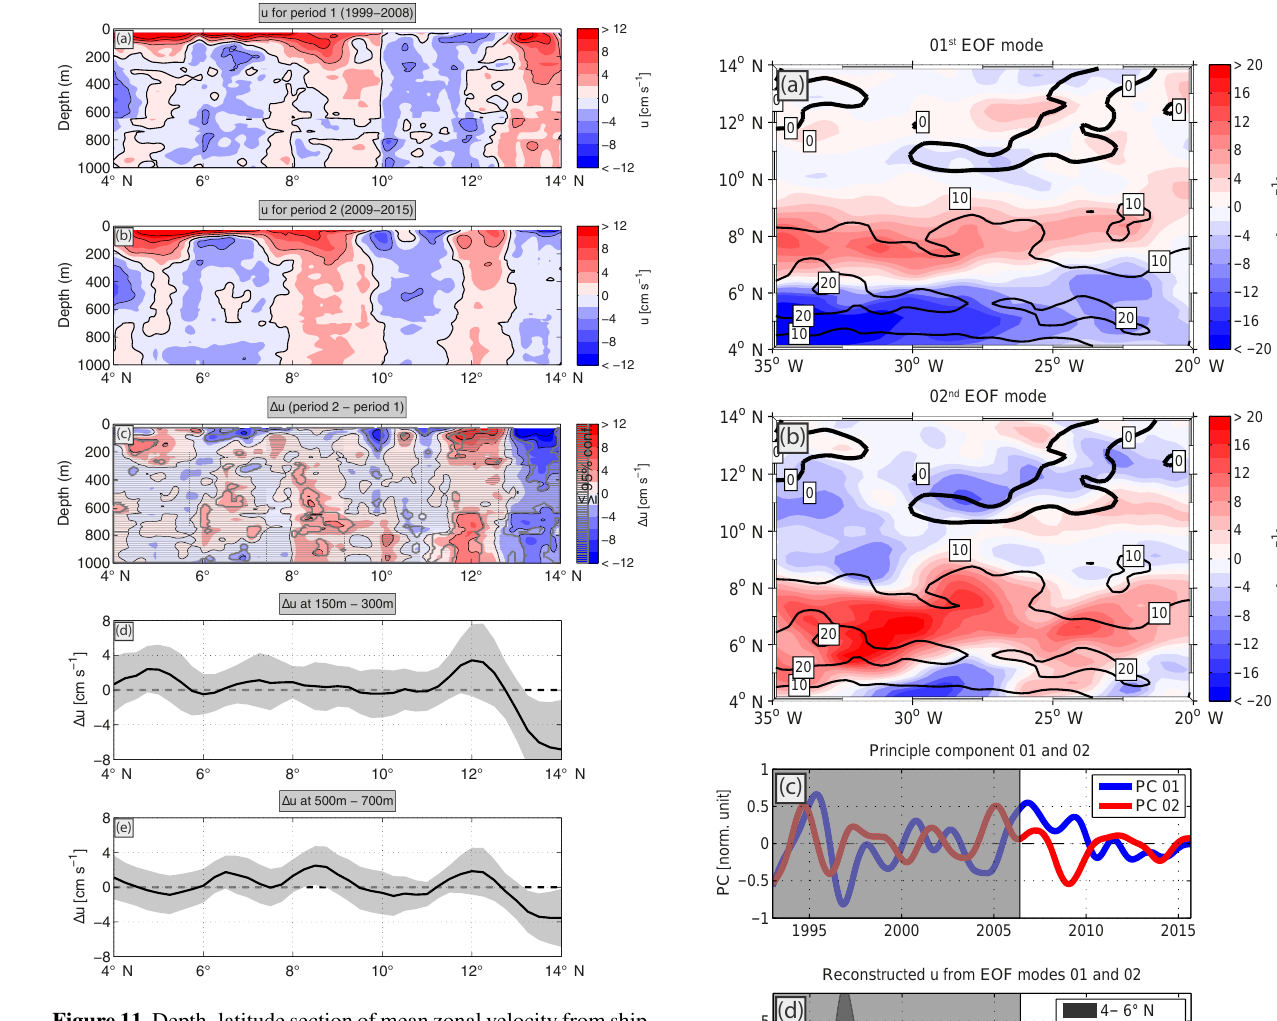
ity between the aforementioned two periods ( (b) minus (a) ). Gray hatching defines non-significant regimes with respect to 95% con- fidence. The interval of the black solid velocity contour lines in (a) to (c) is 4 cms − 1 . (d) Vertical average of (c) for the depth range 150–300m (black line). The gray-shaded area marks the 95% con- fidence band. Panel (e) is the same as (d) but for the depth range 500–700m.